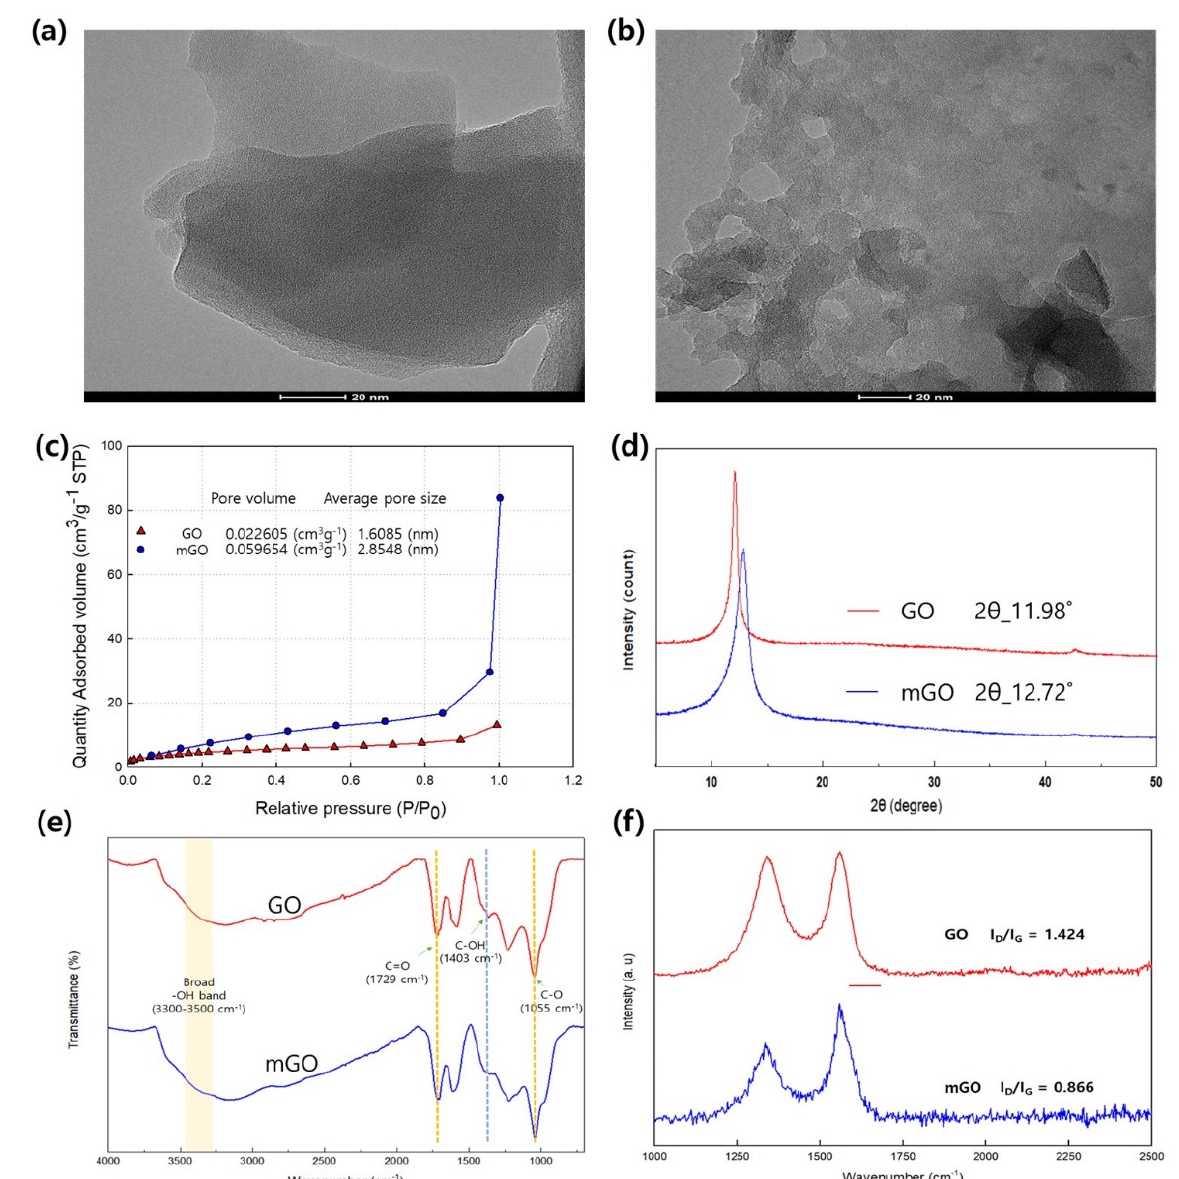
Figure 2. Characterization of GO nanoparticles. ( a ) TEM image of GO (before synthesis), ( b ) TEM image of mGO (after synthesis), ( c ) BET analysis results for GO and mGO, ( d ) XRD analysis results, ( e ) FT-IR analysis results for GO and mGO, and ( f ) Raman spectroscopy analysis results for GO and mGO.